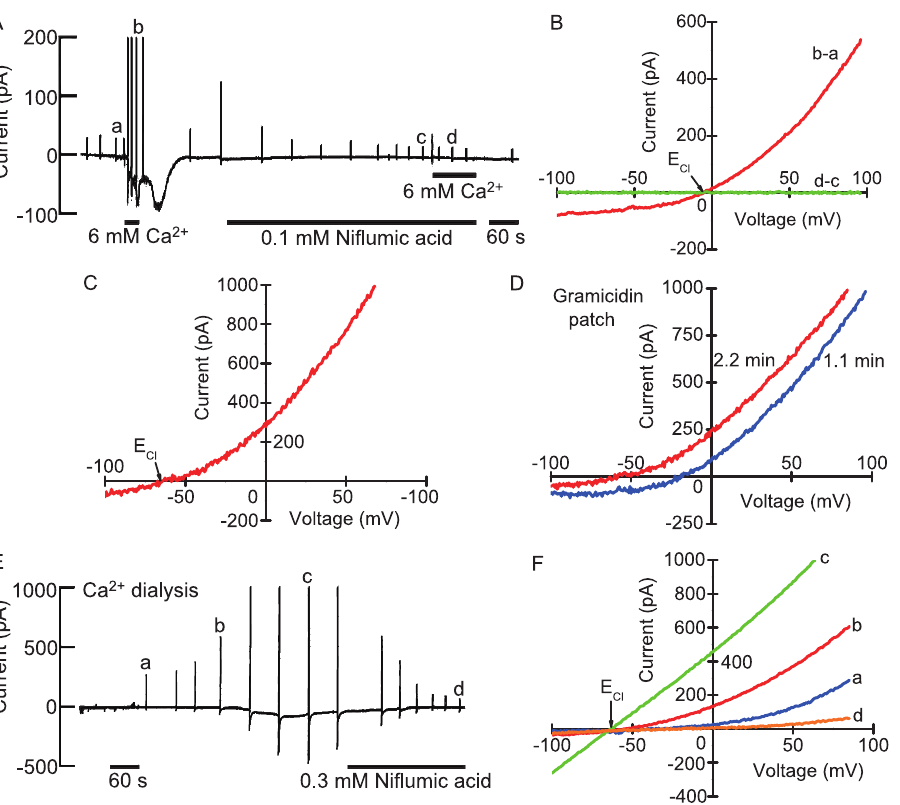
Figure 3. The dependence of the reversal potentials of extracellular Ca 2 + -induced and Ca 2 + dialysis-induced currents on intracellular Cl 2 concentration. (A)The pen recording of the inhibitory effect of niflumic acid on extracellular Ca 2 + -induced current measured at a holding potential of 2 54 mV. (B) The plot of the whole-cell current/voltage ( I/V ) relationships produced by a voltage ramp of the extracellular Ca 2 + - induced currents obtained from the pen recording on the upper. (C) The shift of the reversal potential of extracellular Ca 2 + -induced current in another cell. Intracellular Cl 2 concentration was reduced from 104 to 10 mM. In Figure 3A, B and C, the pipette solution contained amphotericin B (133 m g/ ml). (D)The gramicidin-perforated whole-cell current/voltage ( I/V ) relationships by a voltage ramp of the extracellular Ca 2 + -induced currents. Only in this case, the pipette solution contained gramicidin (100 m g/ml). (E) The pen recording of intracellular 0.8 mM Ca 2 + -induced current and its inhibition with niflumic acid. (F) The plots of I/V relationships produced by a voltage ramp of Ca 2 + dialysis-induced currents. I/V relationships labeled a–d were obtained at the time indicated by the same letters on the pen recording.